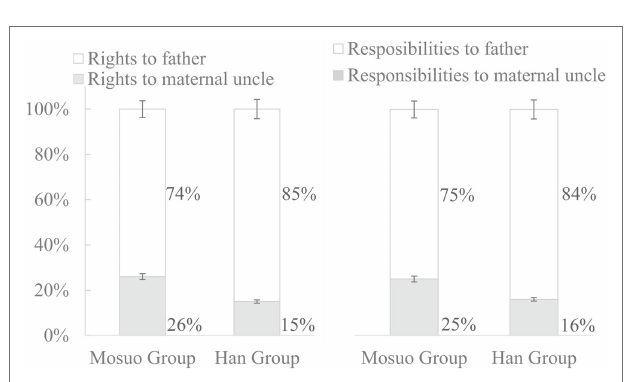
FIGURE 3 | Juvenile participants’ average percentage of the choice on the rights and responsibilities in Study 2. Error bars represent 95% CIs.